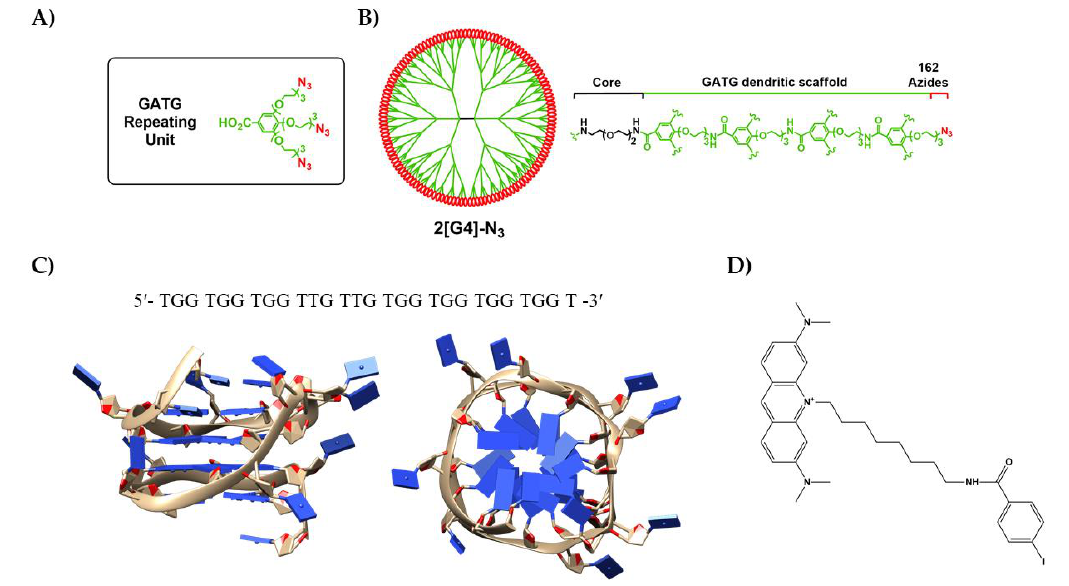
Figure 1. ( A ) Chemical structure of the GATG repeating unit. ( B ) 2[G4]-N 3 dendrimer with 162 ter- minal azides. ( C ) G-rich nucleotide sequence and tridimensional structure of AT11 aptamer (PDB entry 2N3M) and ( D ) chemical structure of 10-(8-(4-iodobenzamide)octyl))-3,6-bis(dimethylamine) acridinium iodide, also known as C 8 .